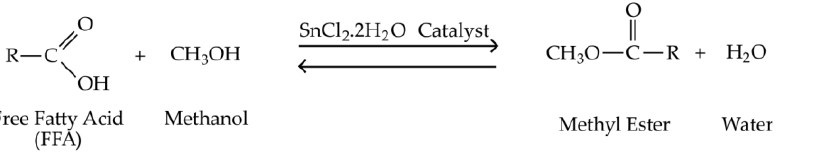
Figure 1. Esterification of FFA with Methanol in the Presence of SnCl 2 .2H 2 O